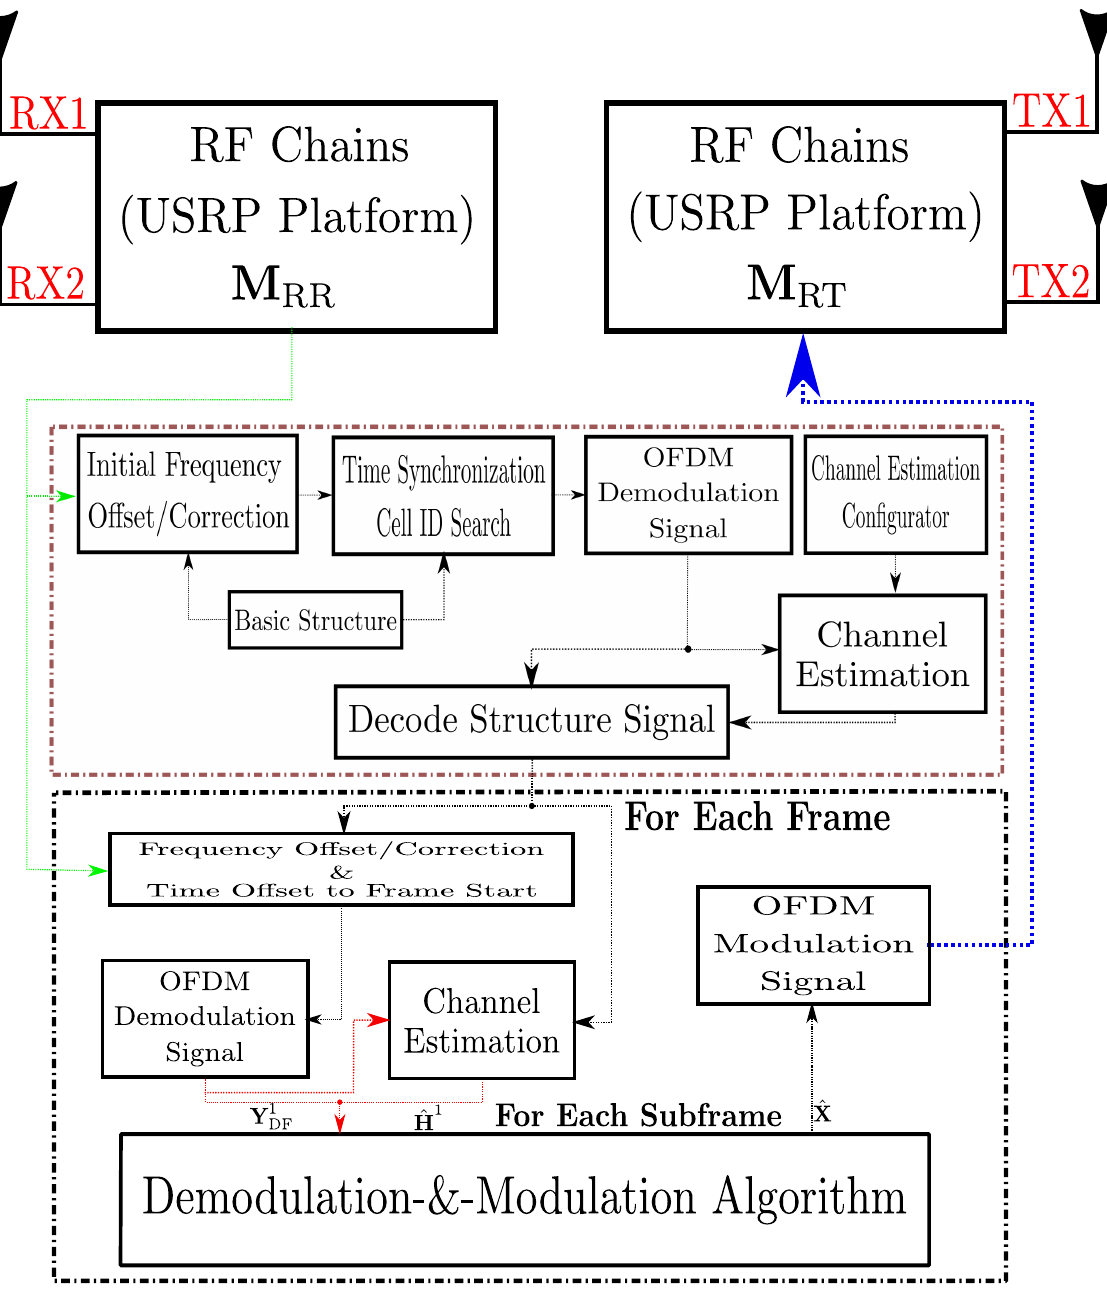
Figure 9. MIMO Decode-&-Forward Relay Node Processing